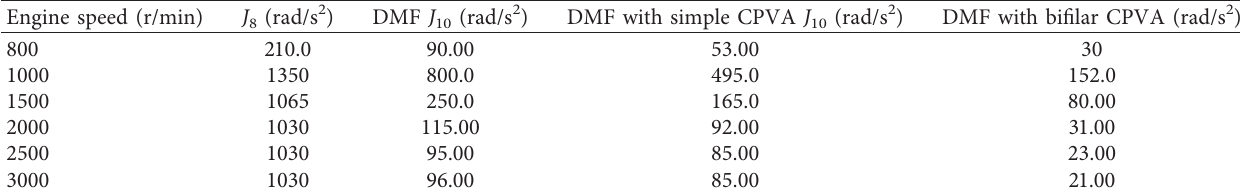
Table 4: The overall angular acceleration amplitudes corresponding to different rotational speeds.